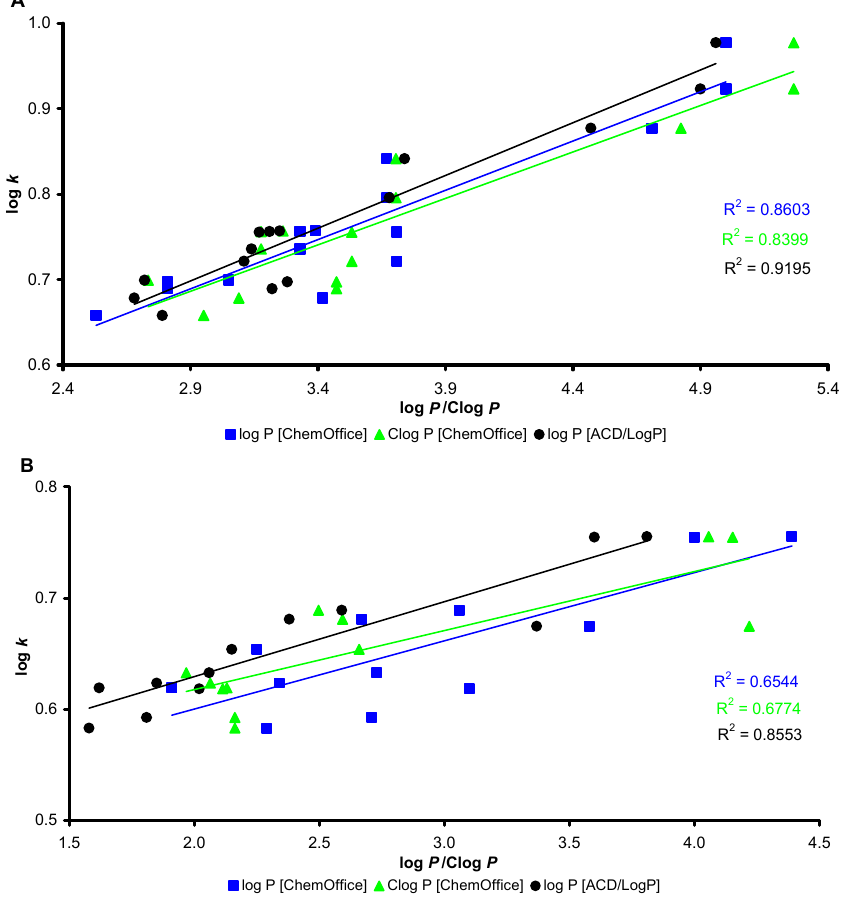
Figure 2. Comparison of log P /Clog P data calculated using two programs with log k values found experimentally. ( A ) match of calculated data with log k values of 3a – o found experimentally; ( B ) match of calculated data with log k values of 4a – l found experimentally.